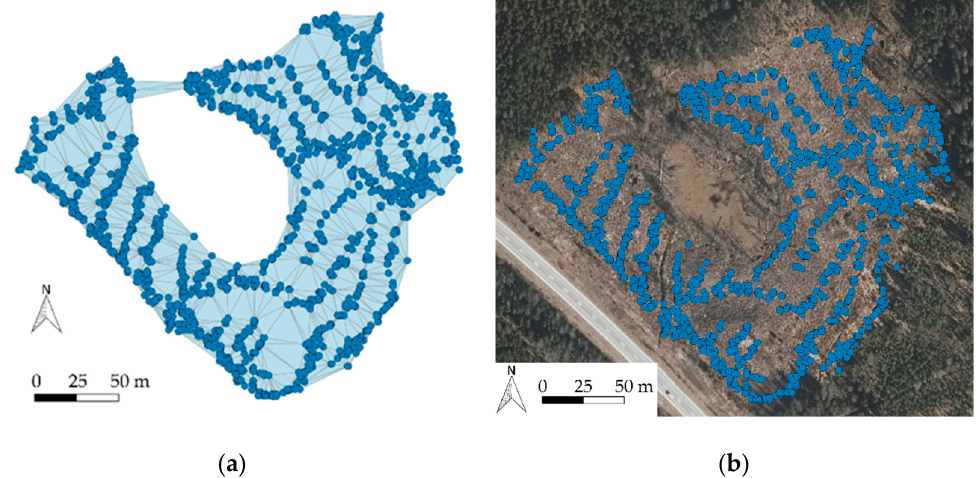
Figure 7. An example of isthmus which has appeared during triangle selection in Algorithm A2 at clear cut object. Harvester was known to have a less accurate GNSS receiver. The ETRS-TM35FIN (EPSG:3067) coordinate system is used in the figure. ( a ) Three triangles have been selected into stand since the tree points at opposite edges of the concave non-harvested area are within the allowed maximum distance of points. ( b ) Aerial image confirms that the area of isthmus has not been clear cut. Aerial image © National Land Survey of Finland.